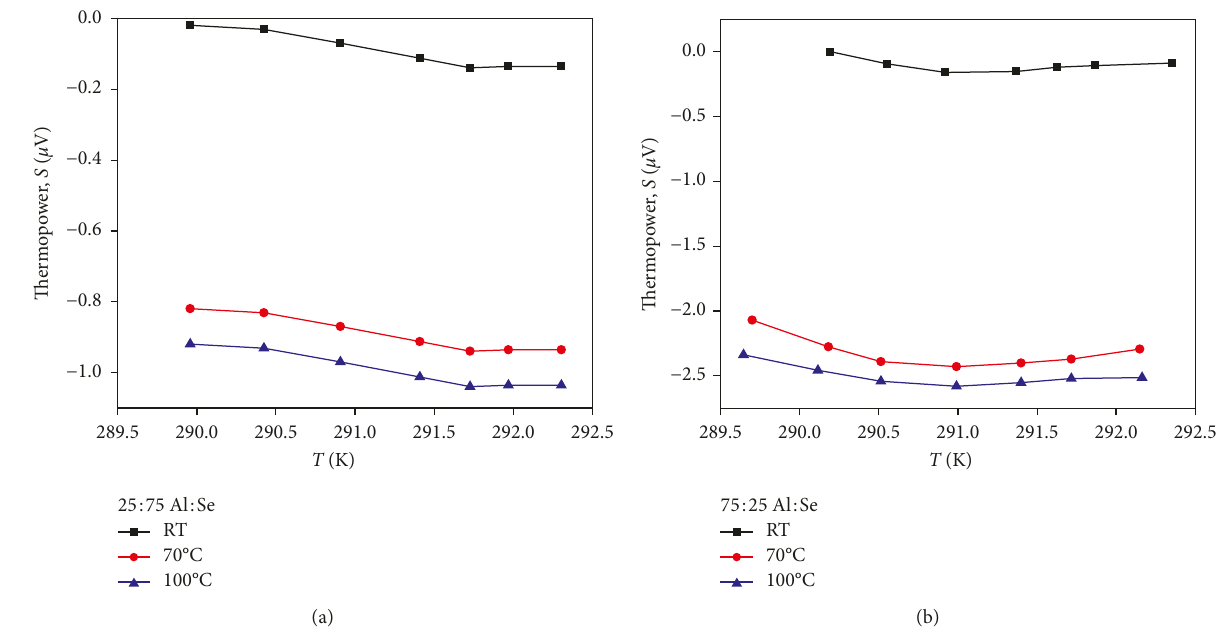
Figure 14: Graph between thermoelectric power and temperature for AlSe: (a) 25:75 and (b)